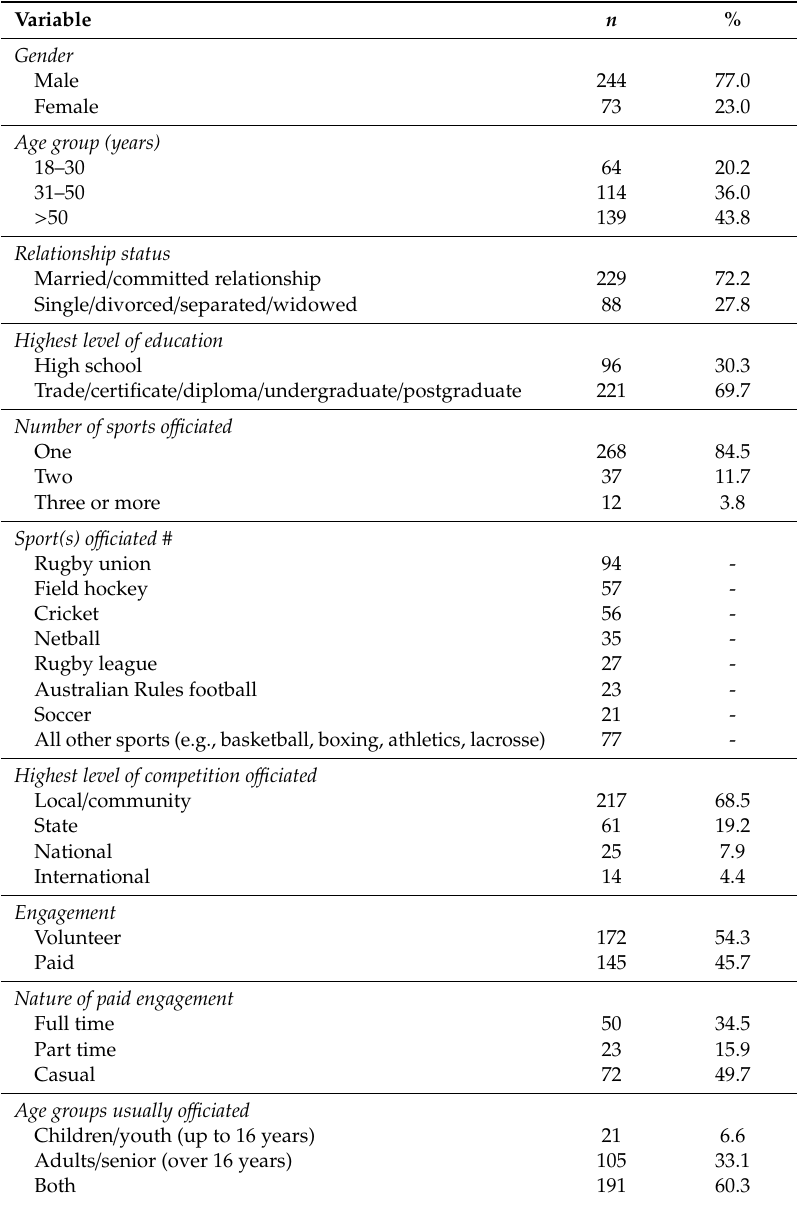
Table 1. Demographic characteristics of